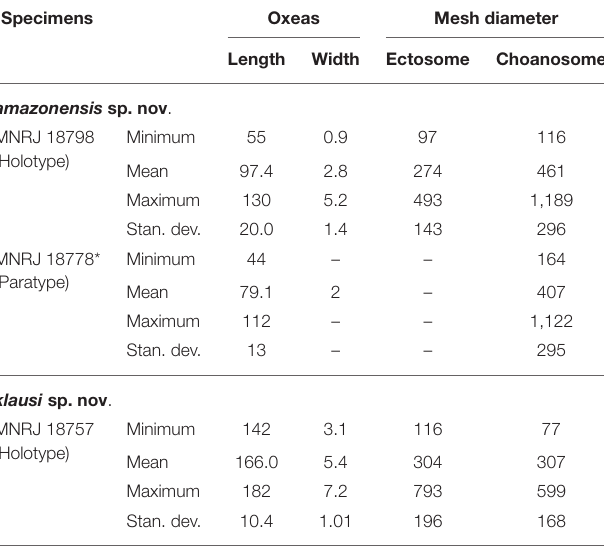
TABLE 4 | Spicule micrometries and mesh diameter ( µ m) for the new species of Arenosclera reported here. Specimens